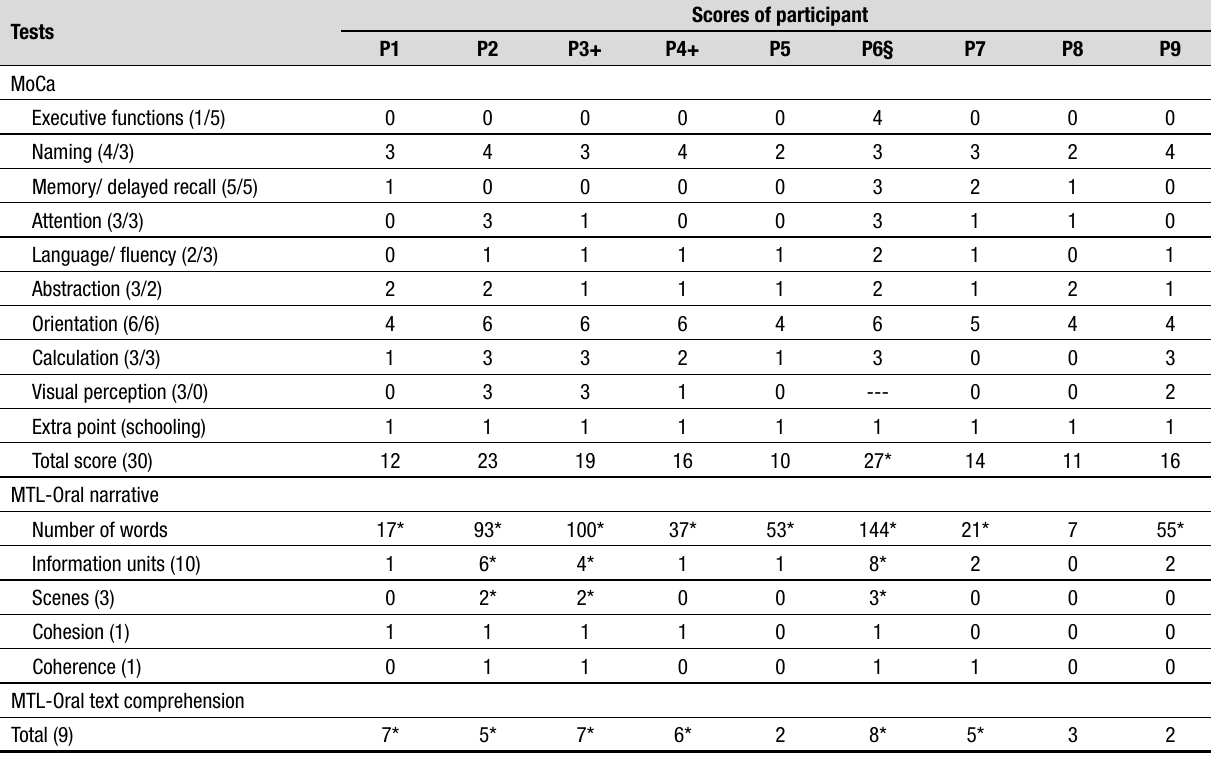
Table 1. Cognitive and linguistic performance of institutionalized